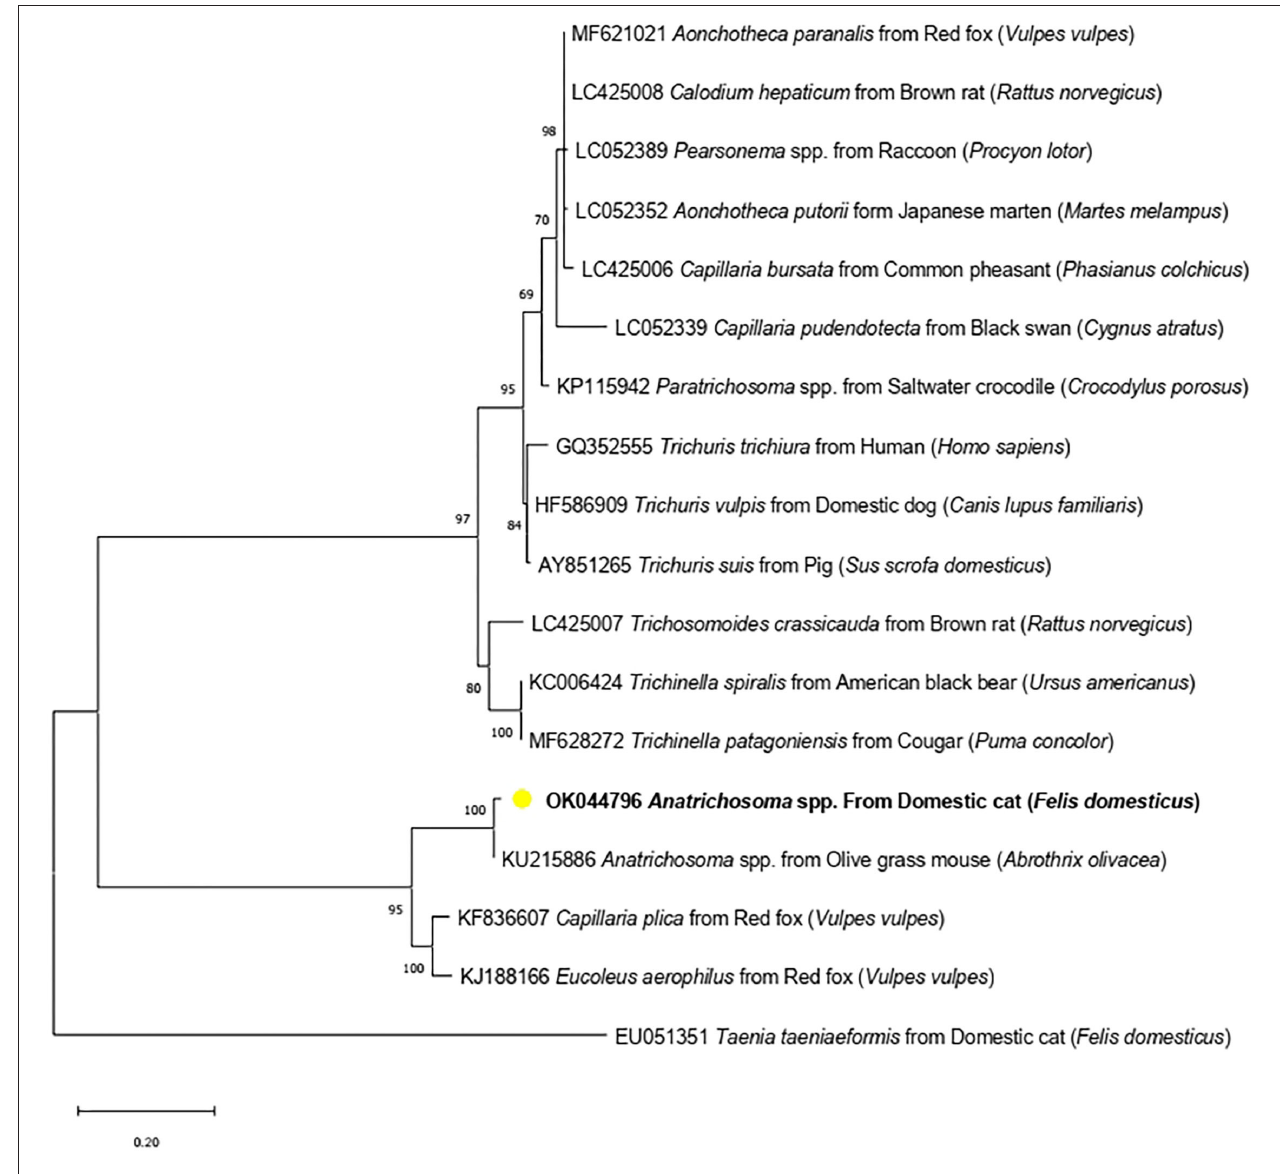
FIGURE 4 | Maximum-likelihood phylogenetic tree showing the genetic relationship between Anatrichosoma spp. in cats (OK044796) (yellow dot) and other Trichinellida nematodes using 18S rRNA gene.